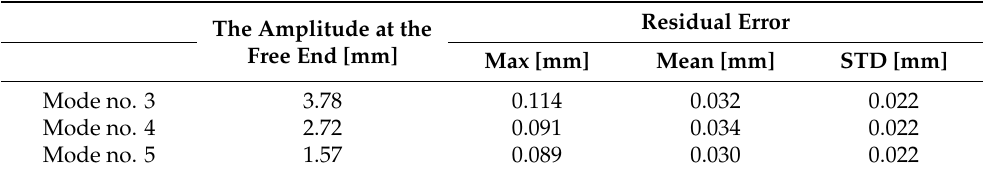
Table 3. Statistical parameters of residual error between synthetic images processing and FEA re- sults for different mode shapes.